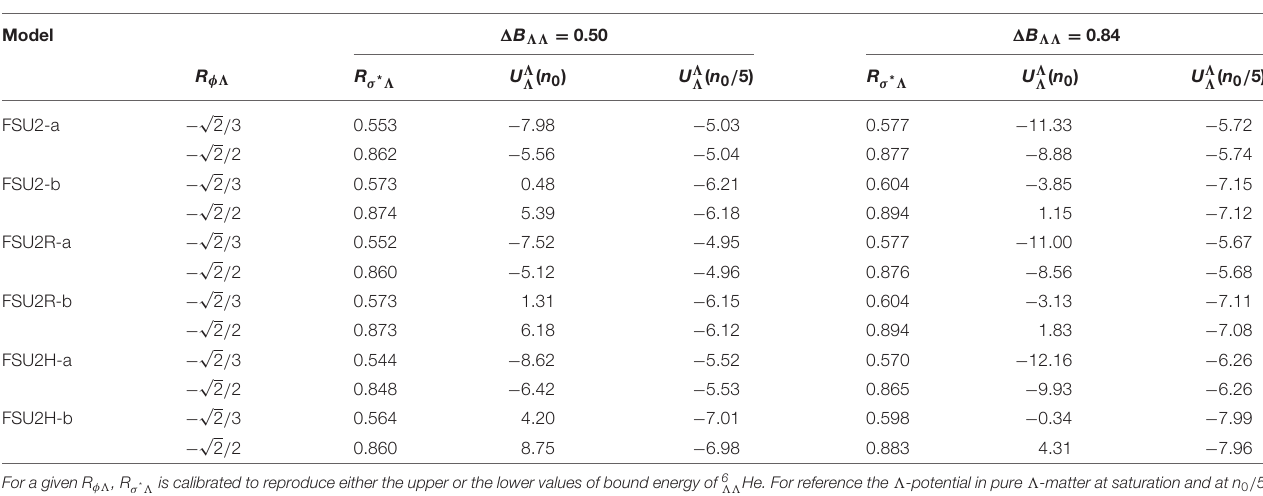
0.50 MeV (solid lines) and 0.84 MeV (dashed lines) for chosen values =